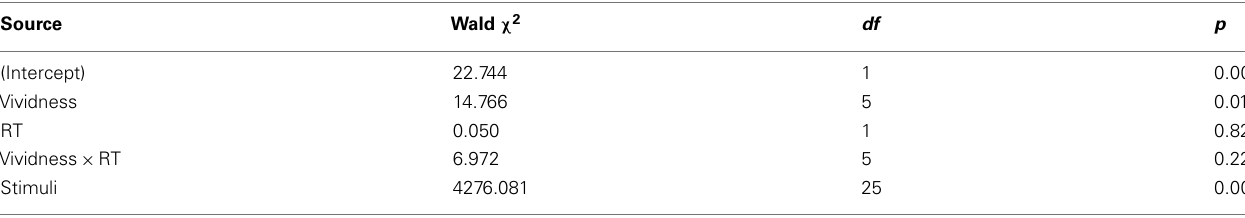
TableA5 |Type III test of model effects for repeated measure logistic regression